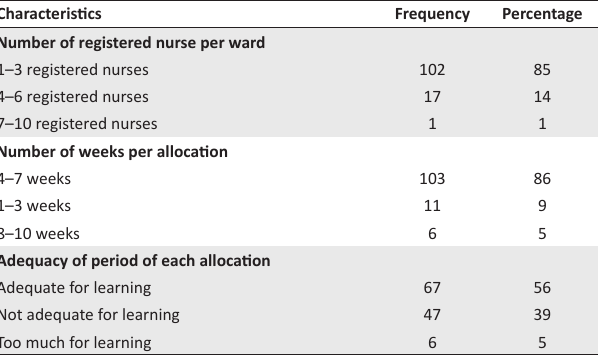
TABLE 2: Demographic characteristics of the clinical learning environment. Characteristics